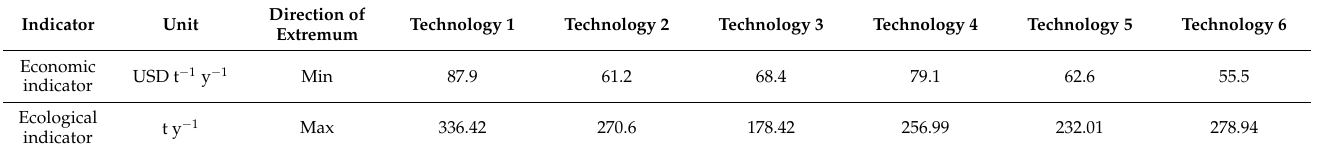
Table 2. The choice of the optimal technology with due account for the technical and land resources of the pig